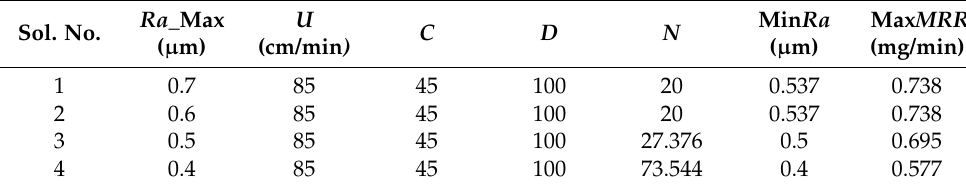
Table 2. Optimal pairs of conventional abrasive flow nano-finishing process parameters obtained using the single-objective virus-evolutionary genetic algorithm (VEGA). Sol. No.